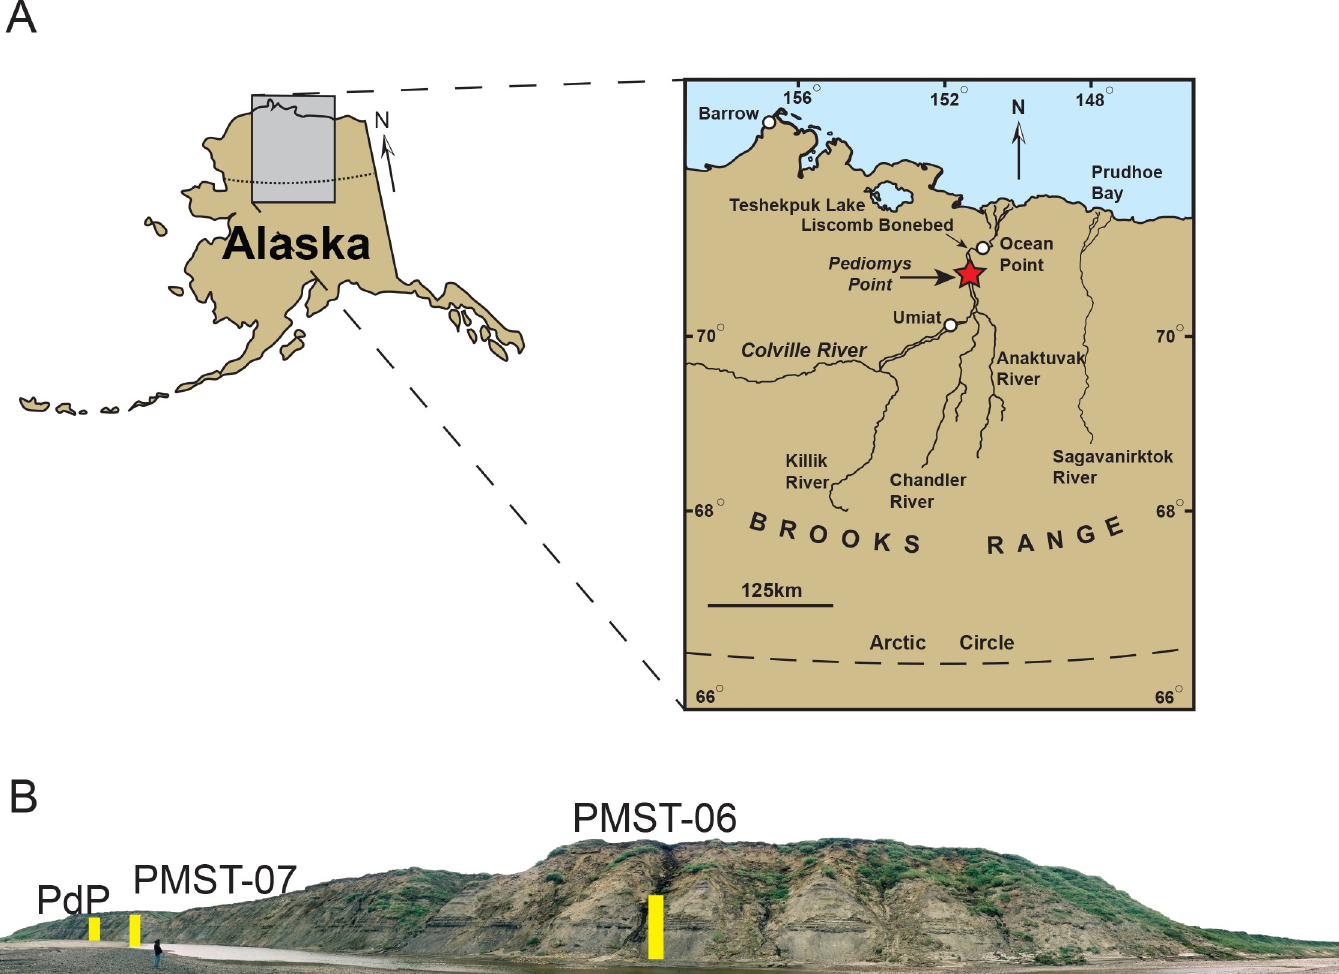
Fig 1. Locality map (A) of Pediomys point (red star) in the North Slope of Alaska, USA. Coordinates: N 70.018667˚, W 151.591488˚ (Paleocoordinates from paleobiodb. org: N 89.13˚, W -104.73˚). Stratigraphic sections schematized in Fig 2 are reported here in B, with PdP representing the fossil bone-bearing section.